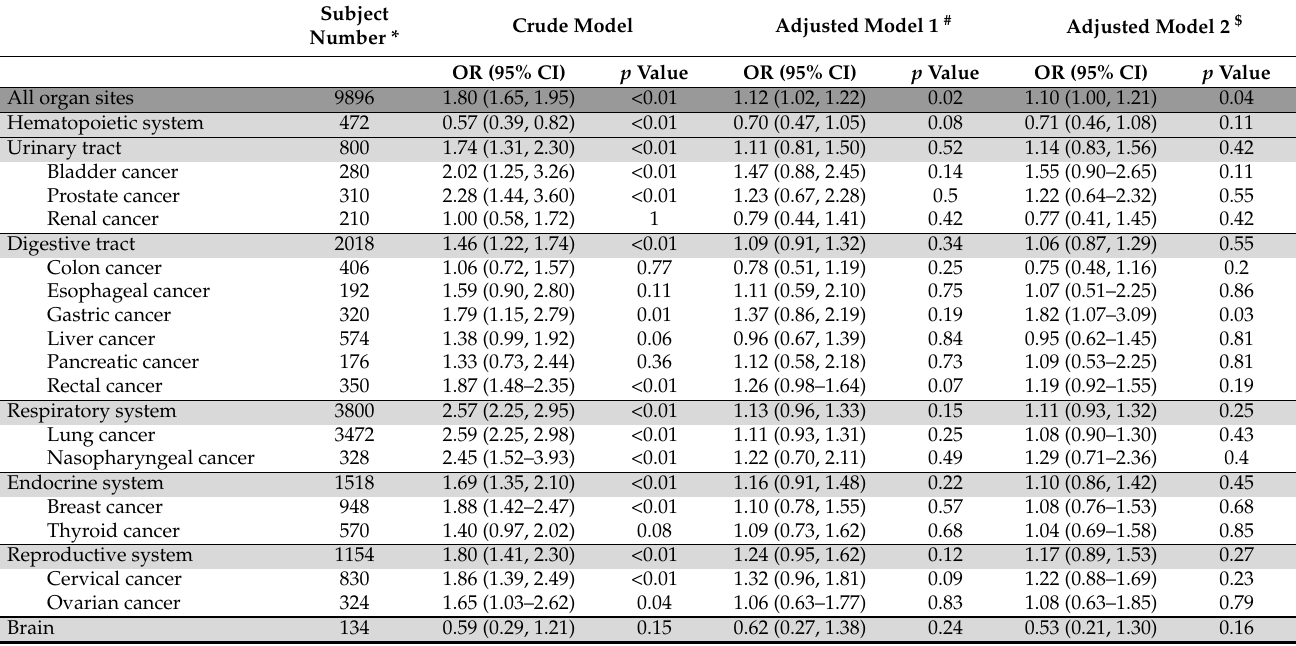
Table 1. Association between HEV exposure and risk of all cancers.